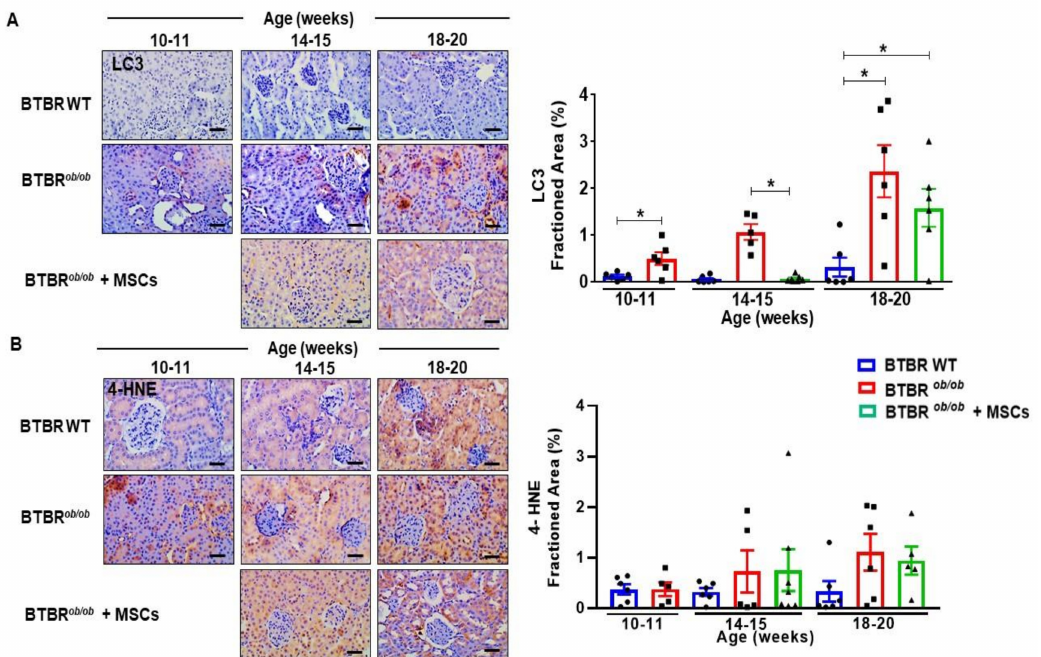
Figure 10. MSC therapy reduces renal LC3 over expression and potentially diminishes renal lipid peroxidation during DKD progression. ( A ) Renal LC3 expression was increased in BTBR ob/ob at any age compared to BTBR (wild-type) WT mice (* p < 0.05). MSC therapy was effective reducing LC3 over induction in 14–15 week-old BTBR ob/ob mice (* p < 0.05). However, the effect did not persist until 18–20 weeks of age. ( B ) 4-HNE staining showed potential increased lipid peroxidation in 14–15 and 18–20 week-old BTBR ob/ob mice, when compared to BTBR WT. However, MSCs therapy did not reduce oxidative stress in these animals. Error bars represent mean ± SEM. For LC3 and 4-HNE staining: n = 5–7 animals. Scale bars represent 20 µ m (A and